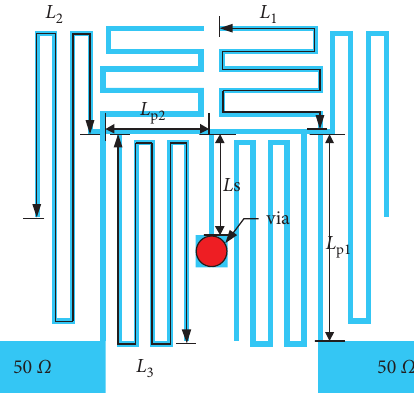
Figure 14: Structure of the proposed sext-band BPF.